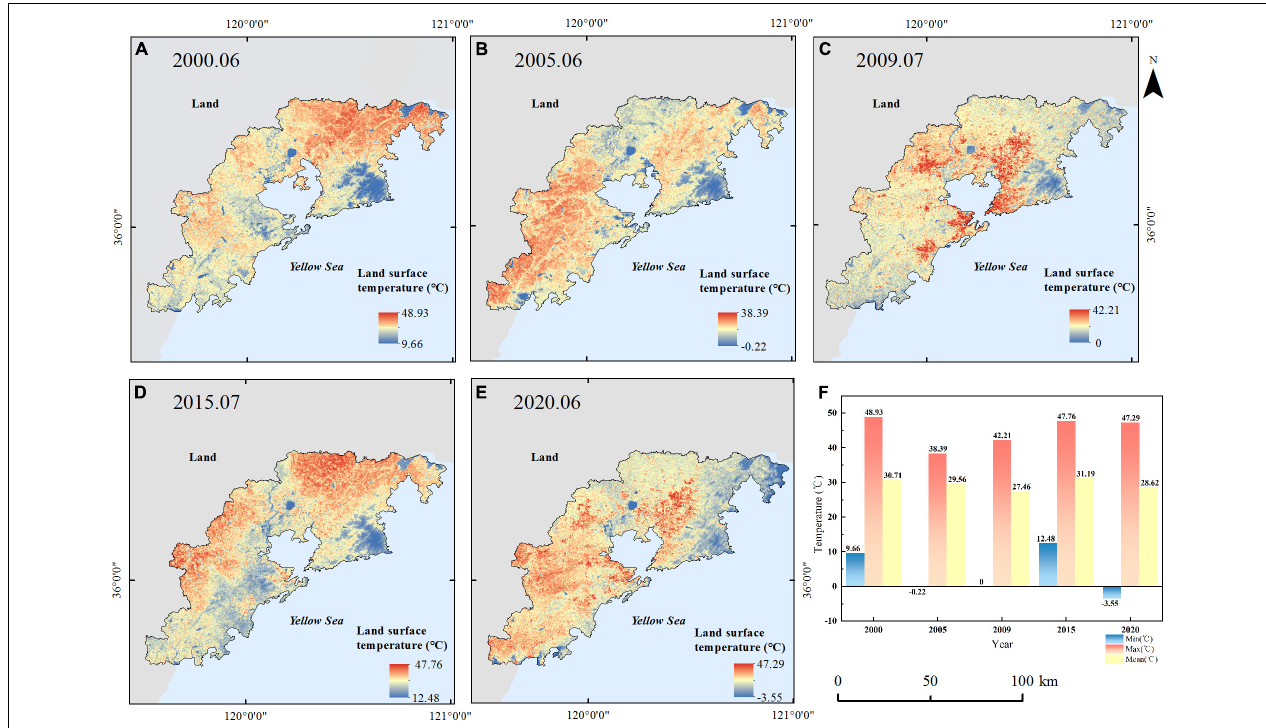
FIGURE 6 | Land surface temperature (LST) in summer from 2000 to 2020 (A) 2000.06, (B) 2005.06, (C) 2009.07, (D) 2015.07, (E) 2020.06, and (F) the max, mean, and min LST in summer from 2000 to